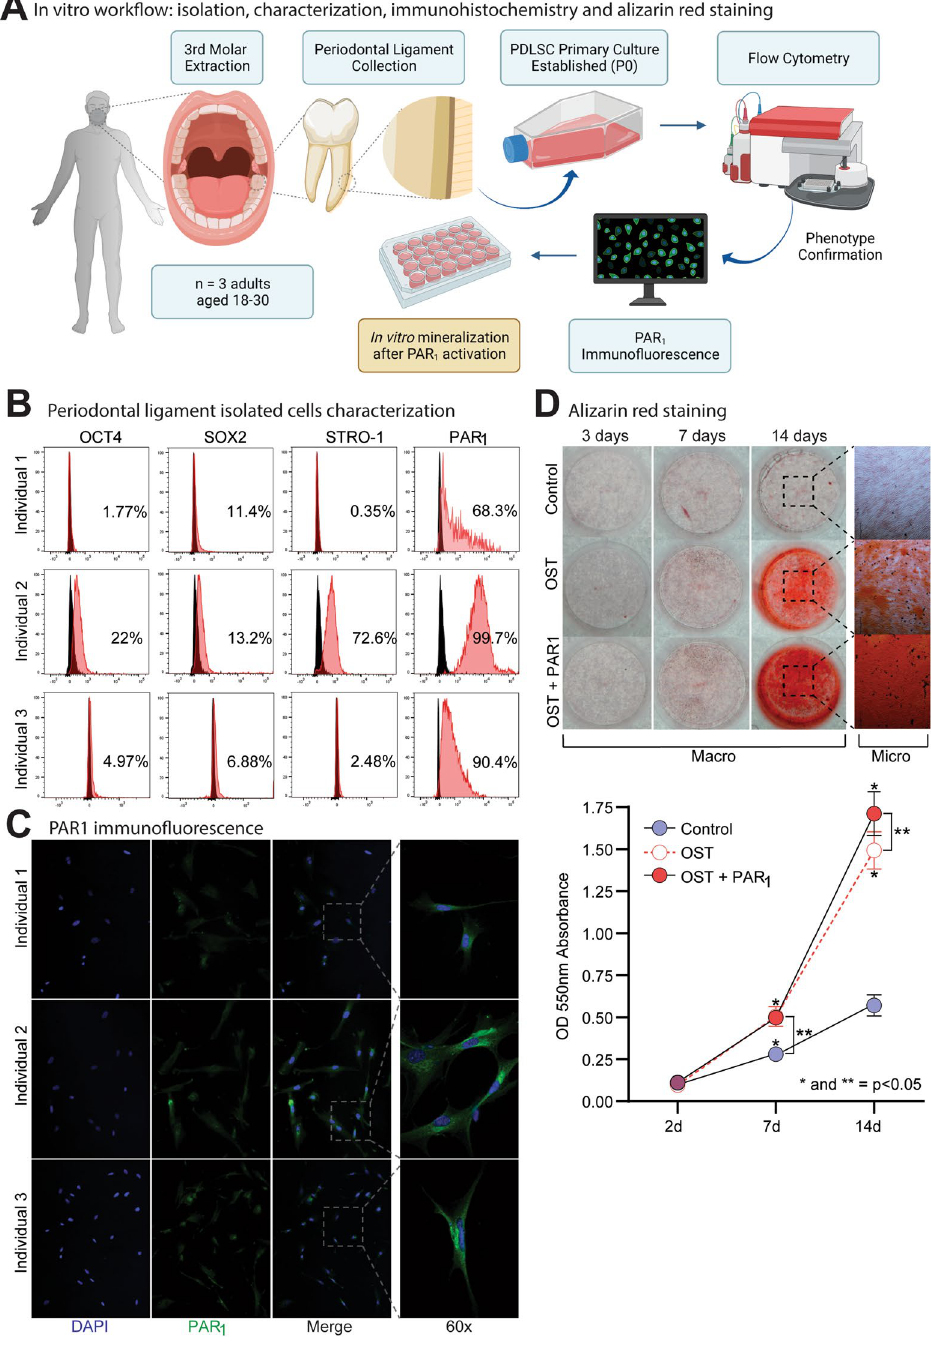
Figure 1. ( A ) Immunofluorescence, flow cytometry and alizarin red staining experiment flow. ( B ) Flow cytometry analysis showing the phenotypic characterization of PDLSCs for surface stemness, multipotent embryonic biomarkers (SOX2, OCT4, STRO-1) and PAR 1 from three individuals (I1, I2 and I3). Unstained cells were used to set positive cell populations, p < 0.05. ( C ) PAR 1 immunofluorescence expression in PDLSCs isolated cell lines. Images in 60X magnification. ( D ) Alizarin red staining for PDLSCs sheets (I2) after 14 days. Results are given as the mean ± SD. Figure ( A ) was created using